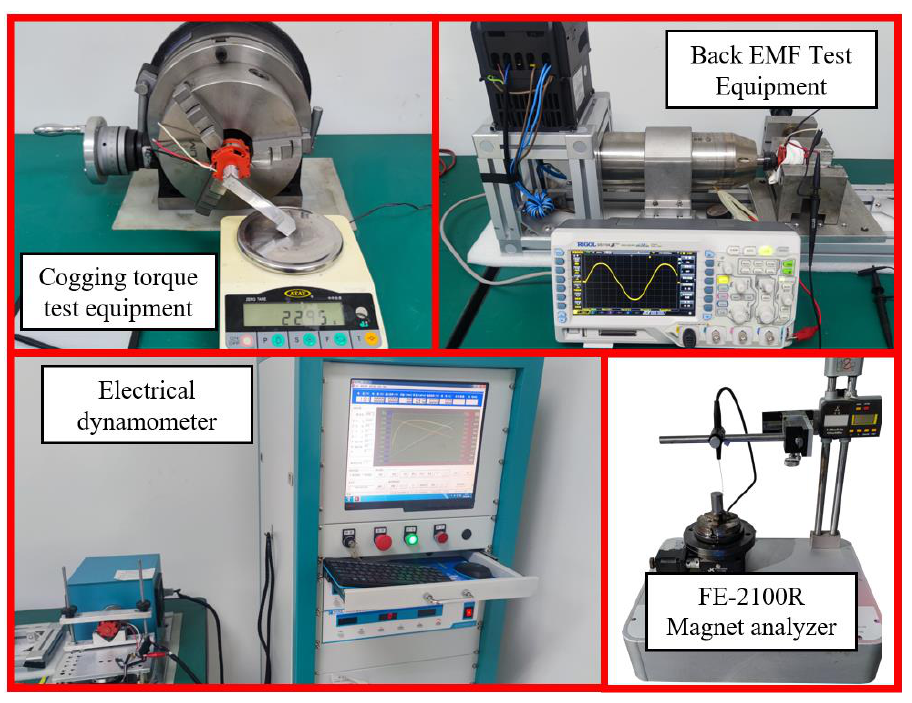
Figure 14. Test equipment.